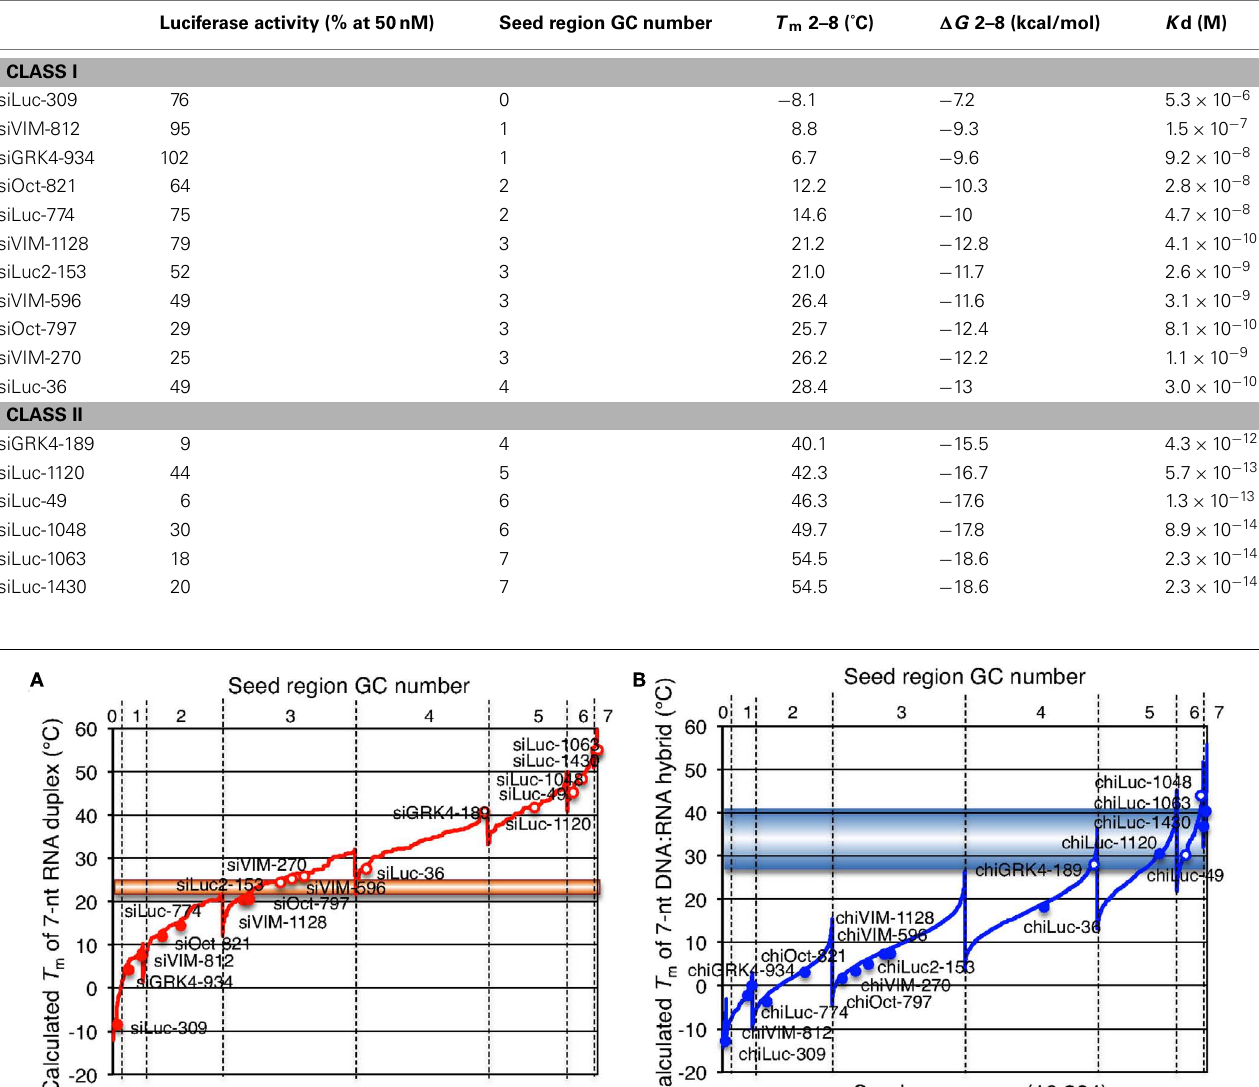
Table 1 | Relative luciferase activities and T ms, Δ G s, and K ds at seed regions of class I and II siRNAs.